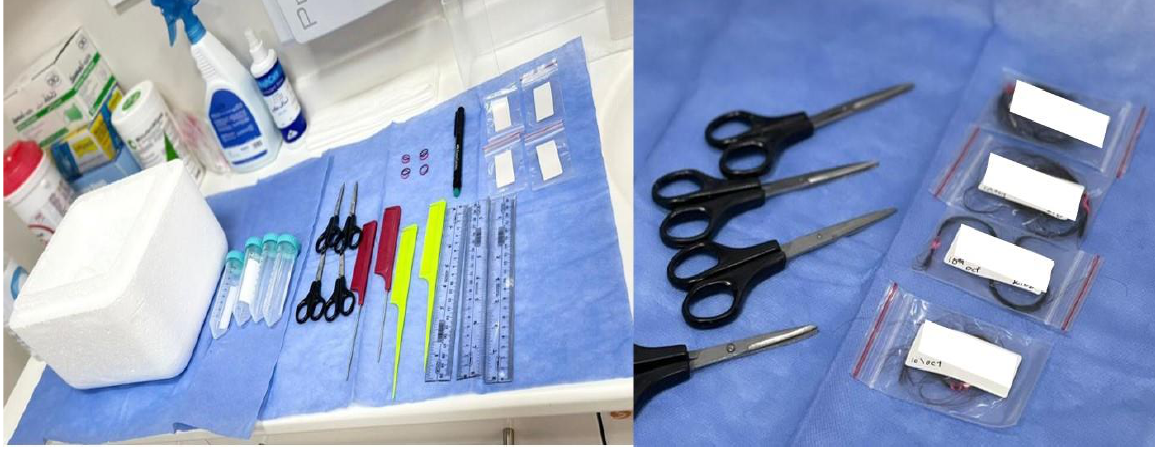
Figure 2. Collection tools for hair samples and some hair collections.